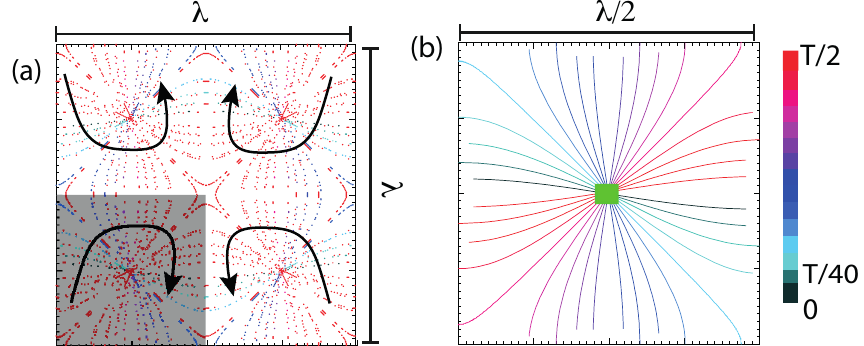
Figure 3. Isolines of the surface elevation at z = 0 with a phase shift of π /2. ( a ) within one cell of size λ × λ . ( b ) Within a λ /2 × λ /2 unit cell. The isolines are shown for half a period of the wave T /2. Different colors denote different times.